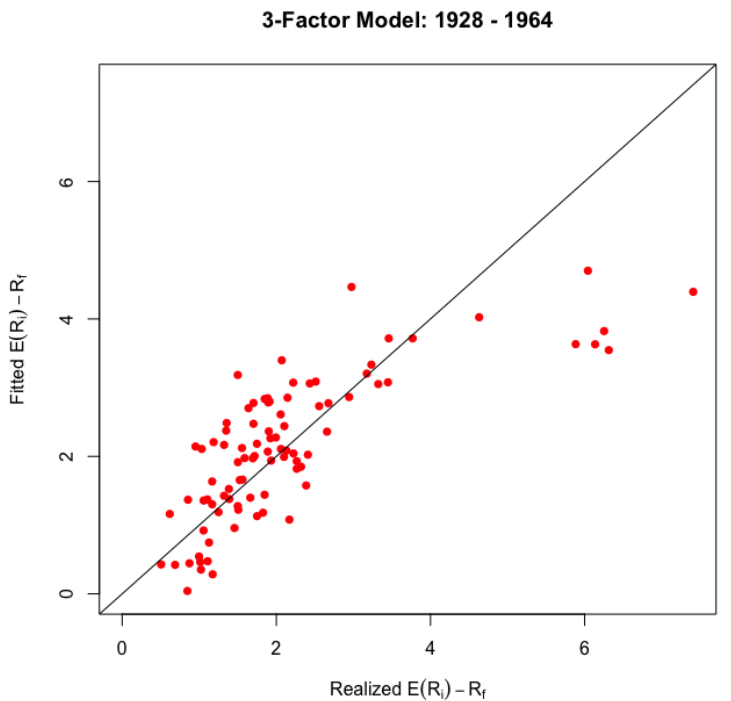
Figure 4. Out-of-sample cross-sectional relationships for the Fama and French three-factor model between average one-month-ahead fitted (predicted) excess returns in percent ( y -axis) and average one-month-ahead realized excess returns in percent ( x -axis): January 1928 to December 1964.